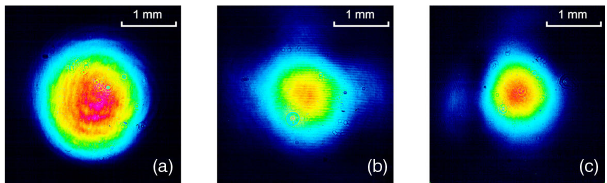
FIG. 10. (a) A spatial UV beam profile right after the laser at 2.8 MW peak power. (b) First beam profile at the interaction point. (c) Second beam profile at the interaction